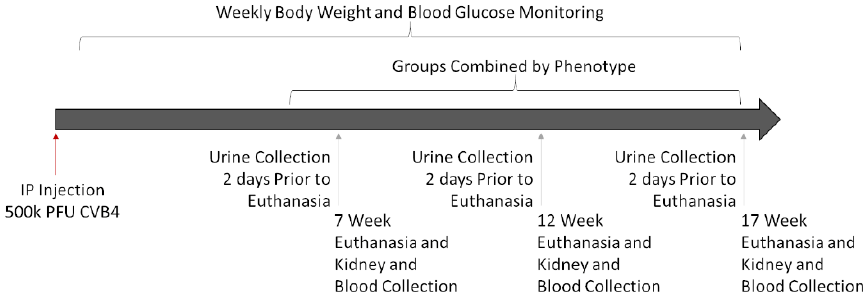
Figure 1. Graphical workflow of animal study: Eighteen female NOD mice were IP-injected with 500,000 PFUs of CVB4 at 10 weeks of age. Mice were euthanized at 7, 12, and 17 weeks post-injection, and assessed as described below. Three timepoints were combined into one group per phenotype (V( − )ND, V( − )DB, V(+)ND, and V(+)DB), because blood glucose and CVB4 were not dependent on